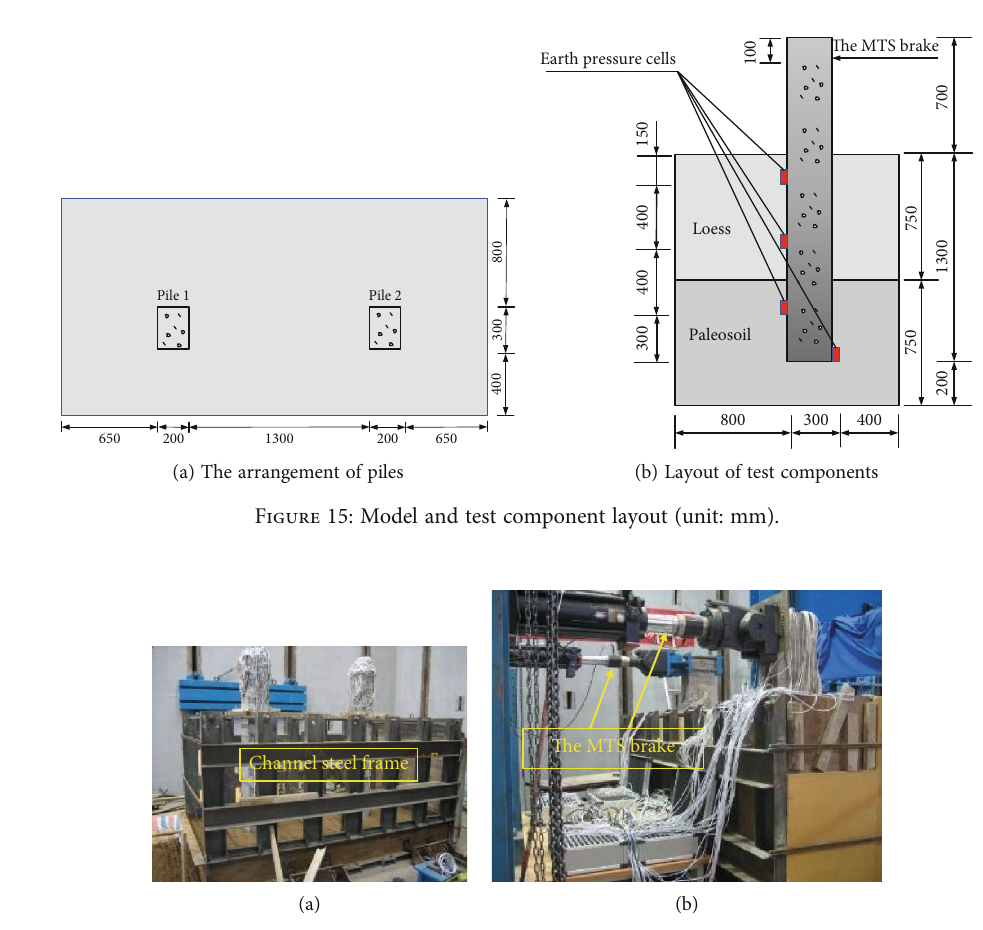
Figure 16: Schematic diagram of layout and loading of model